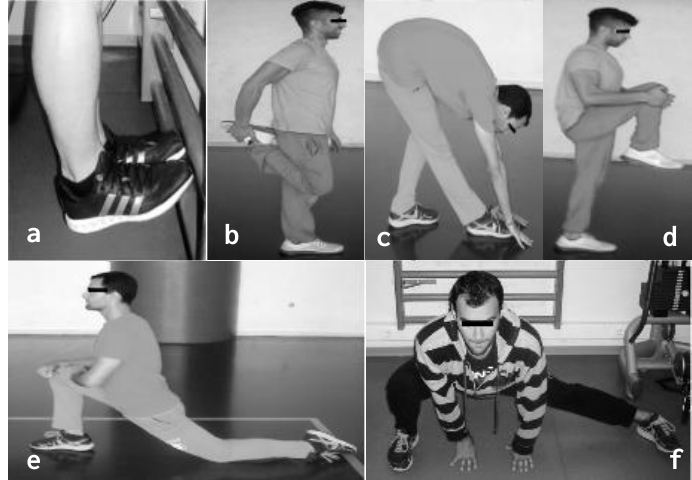
Figure 1. Static stretching protocol exercises of the ( a ) posterior tibial, ( b ) front crural, ( c ) posterior crural, ( d ) gluteus, ( e ) iliopsoas, and ( f ) topside muscles.